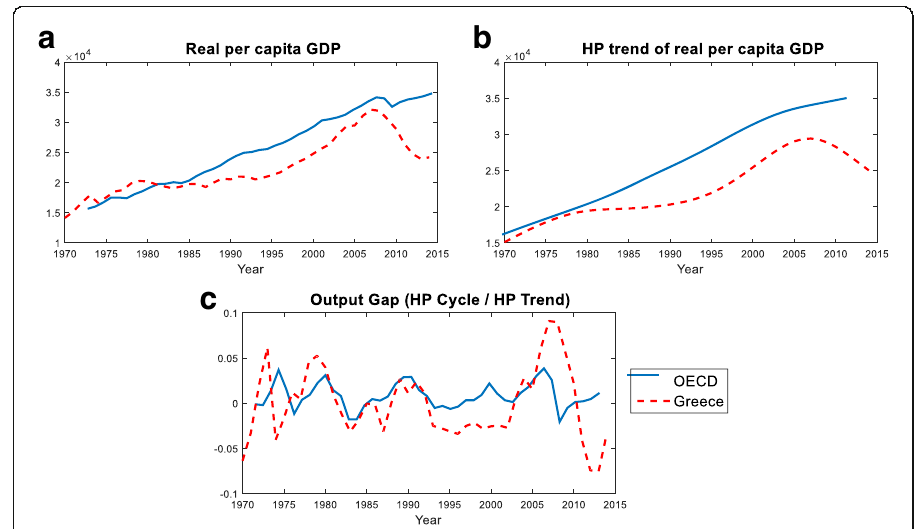
Fig. 1 Real per capita GDP in PPP values (1970 – 2014). a Annual data over the period 1970 – 2014. b Per capita GDP is in constant 2010 prices, constant PPPs, and detrended with the HP filter with a smoothing parameter of 100. c Output gap is defined as the ratio of the HP filter cyclical component over the corresponding HP